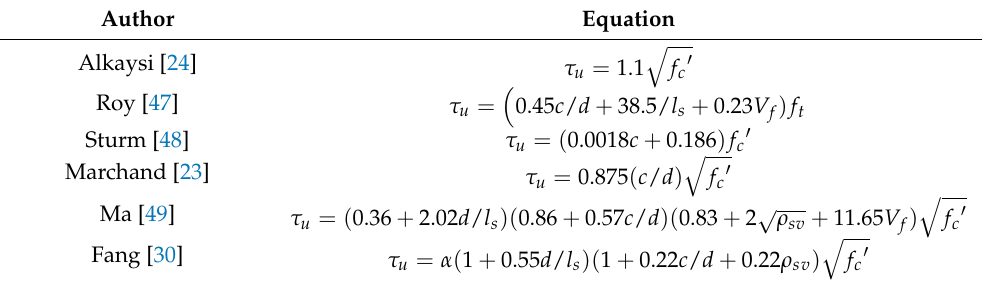
Table 4. Equations of bond strength between steel bar and